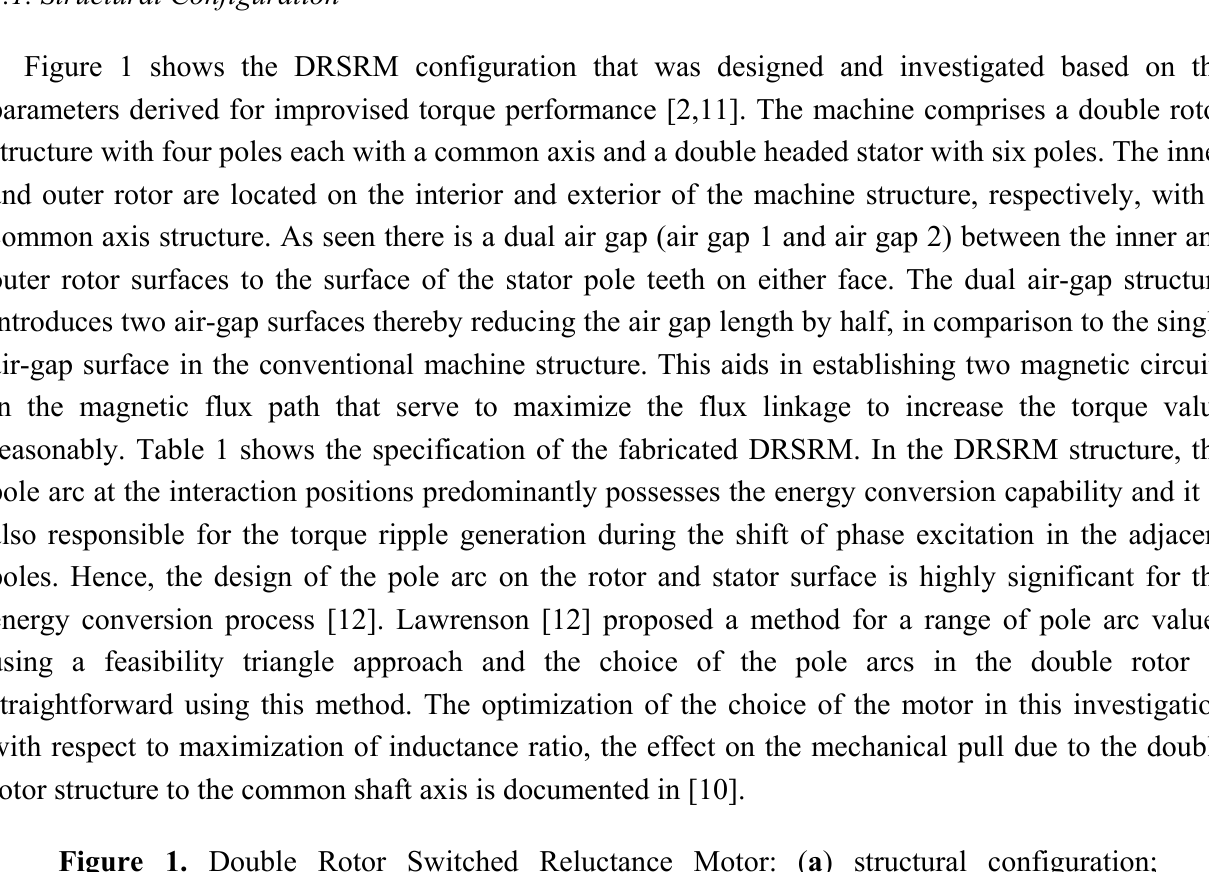
Figure 1. Double Rotor Switched Reluctance Motor: ( a ) structural configuration; ( b ) exploded view of the DRSRM; ( c ) outer rotor; ( d ) inner rotor with stator and coils. Outer rotor ShaftAir-gap2Air-gap1 Stator CoilInner rotor CA B’C’ B A’